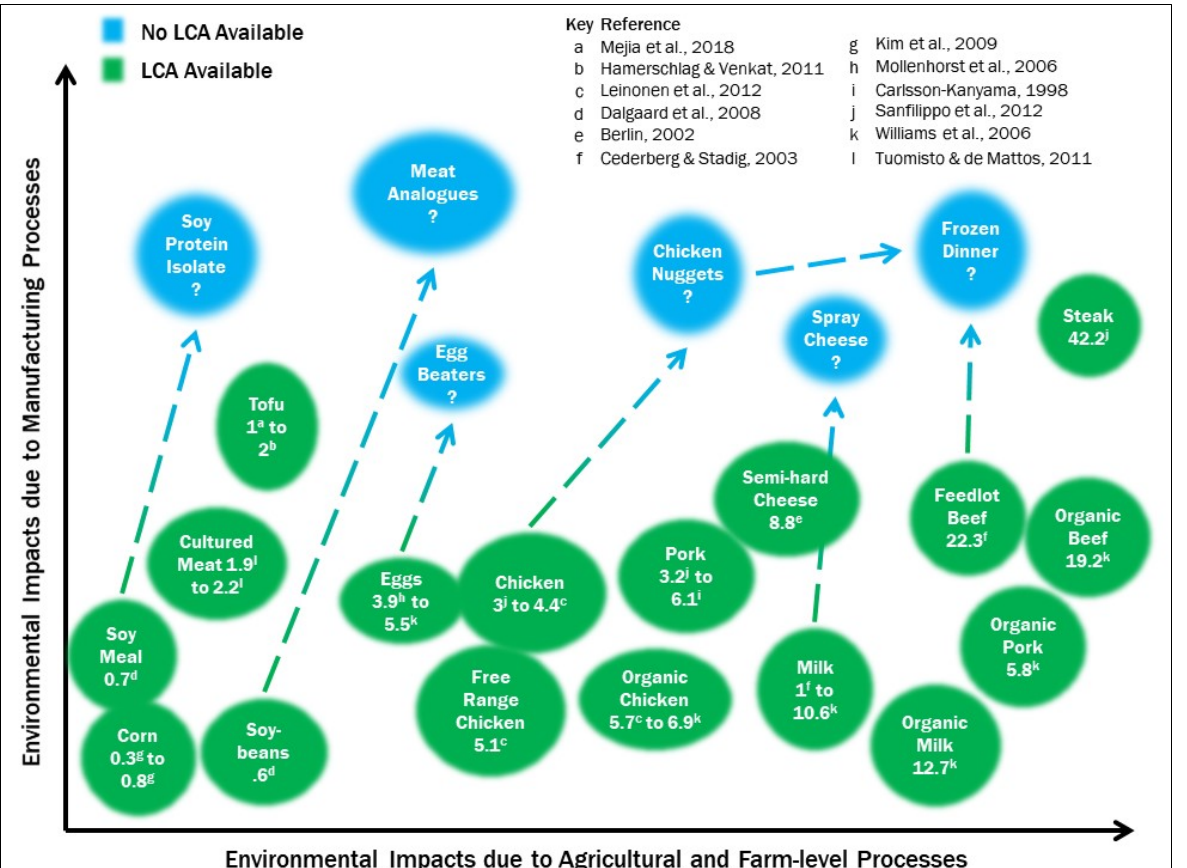
Figure 1. Greenhouse Gas Emissions (kg CO 2 equivalents) from Selected Foods. Most LCA evaluates commodities with minimal manufacturing processes. Value ranges are from references listed in the key (Berlin, 2002; Carlsson-Kanyama, 1998; Cederberg & Stadig, 2003; Dalgaard et al., 2008; Hamerschlag & Venkat, 2011; Kim, Dale, & Jenkins, 2009; Leinonen, Williams, Wiseman, Guy, & Kyriazakis, 2012; Mejia et al., 2018; Mollenhorst, Berentsen, & De Boer, 2006; Sanfilippo, Raimondi, Ruggeri, & Fino, 2012; Tuomisto & de Mattos, 2011; Williams, Audsley, & Sandars,